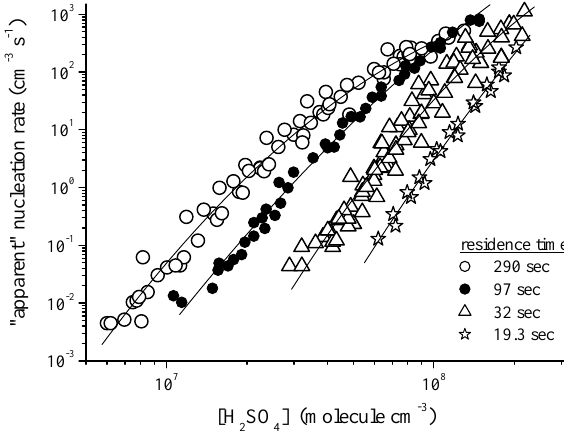
Fig. 3. Total particle numbers for different additives for ad- justing OH levels in the flow tube; total gas flow: 3.33 litre